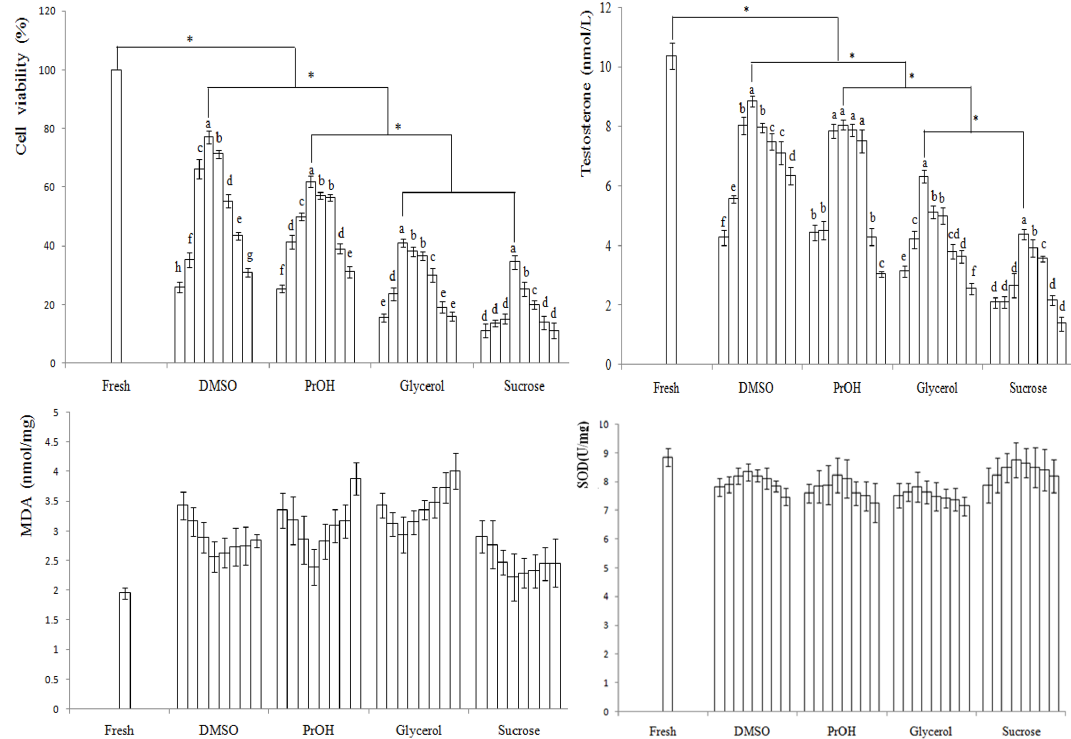
Figure 1. Cell viability, testosterone production, MDA, and SOD level in cryopreserved calf testis with different cryoprotectants. The concentration (abscissa) of each cryoprotectant increased from 2.5 to 20%. All data are presented in mean percentage ± SD; ∗ P< 0 . 05; DMSO: dimethyl sulfoxide; PrOH: propylene glycol.